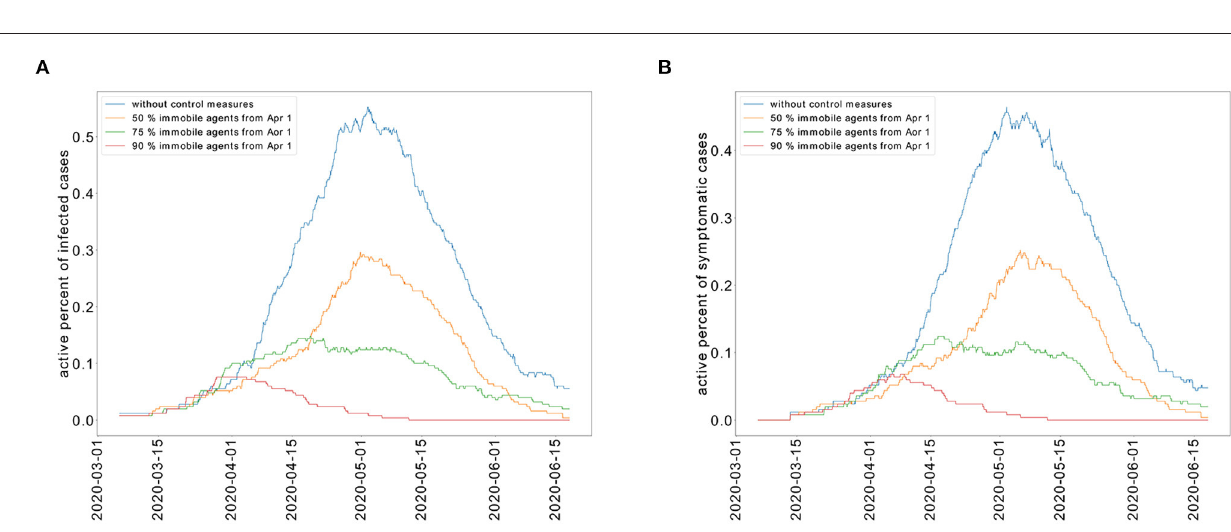
FIGURE 6 | Effect of limited movement of the population on the cumulative percent of infected individuals.